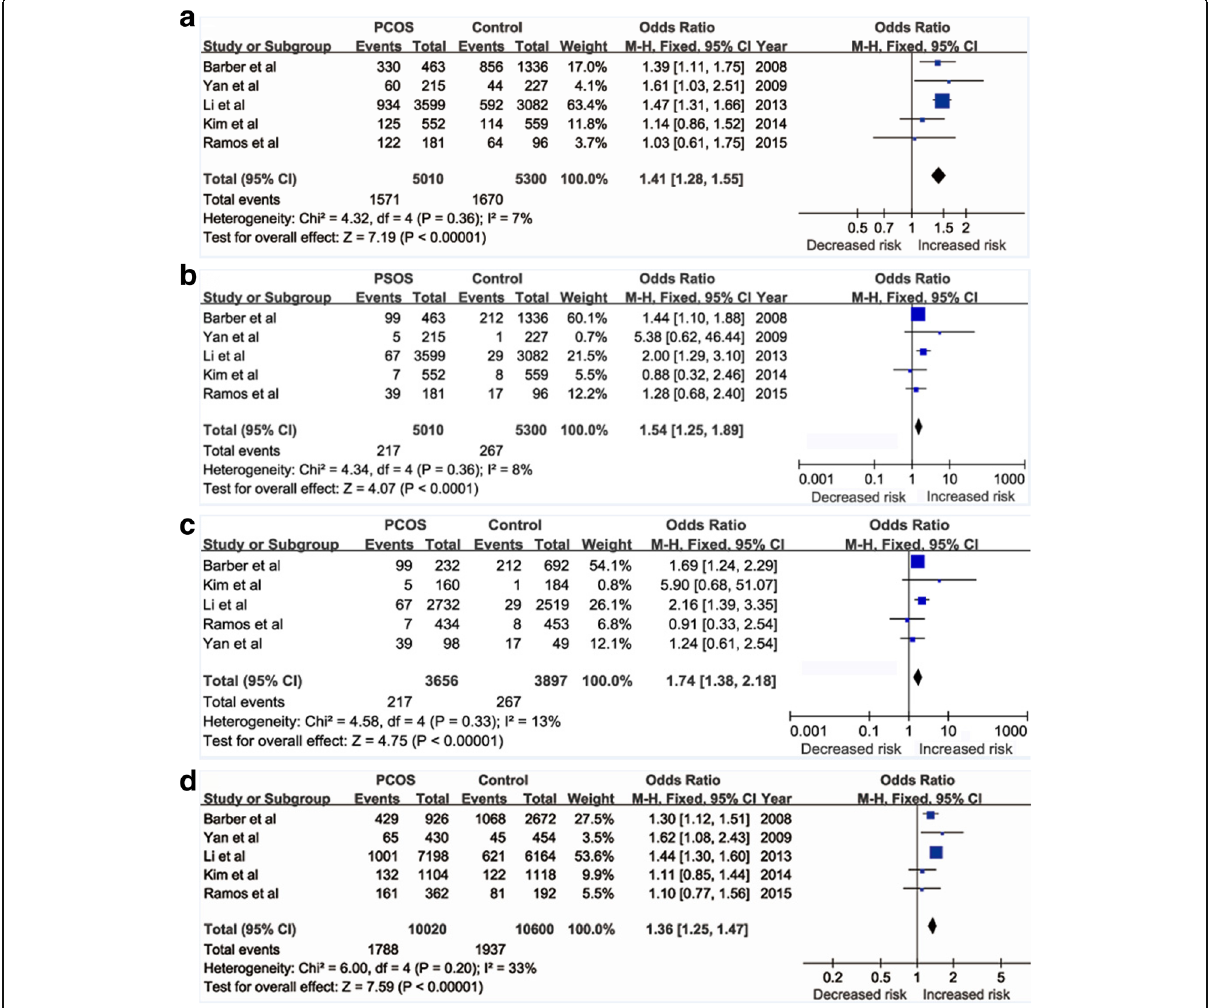
Fig. 2 The association between FTO rs9939609 A/T polymorphism and risk of PCOS. ( a ) AA + AT vs. TT in overall analysis, ( b ) AA vs. AT + TT in overall analysis, ( c ) AA vs. TT in overall analysis, ( d ) A vs. T in overall analysis. For each study, the solid squares represent the ORs from the individual studies, horizontal lines represent corresponding 95% CIs. The pooled ORs and 95% CIs are shown by the shaded